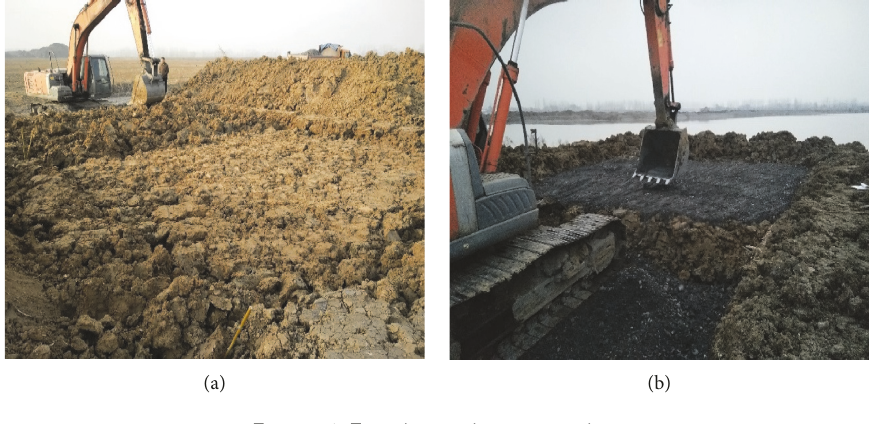
Figure 4: Experiment site